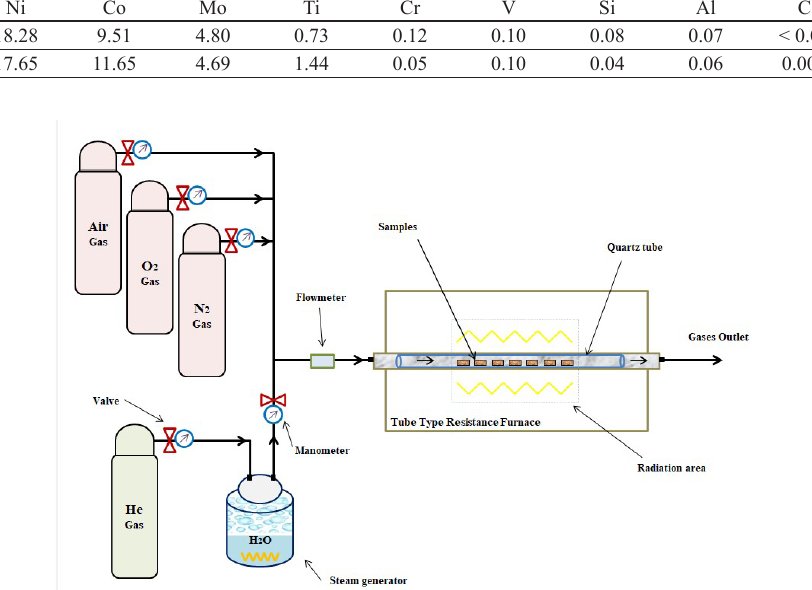
Figure 1. Experimental configuration of the devices for the aging heat